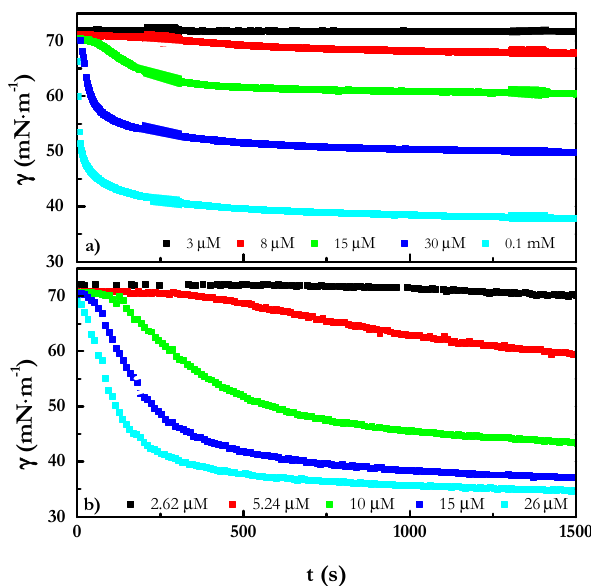
Figure 3. Dynamic surface tension isotherms as were obtained using a drop shape tensiometer for the adsorption of PDADMAC–surfactant mixtures, with different surfactant concentrations, at the liquid/vapor interface. ( a ) PDADMAC–SLMT and ( b ) PDADMAC-SLES.